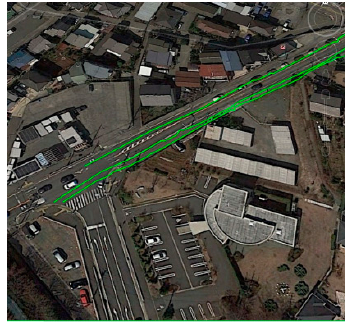
ISPRS Int. J. Geo-Inf. 2018 , 7 , x FOR PEER REVIEW